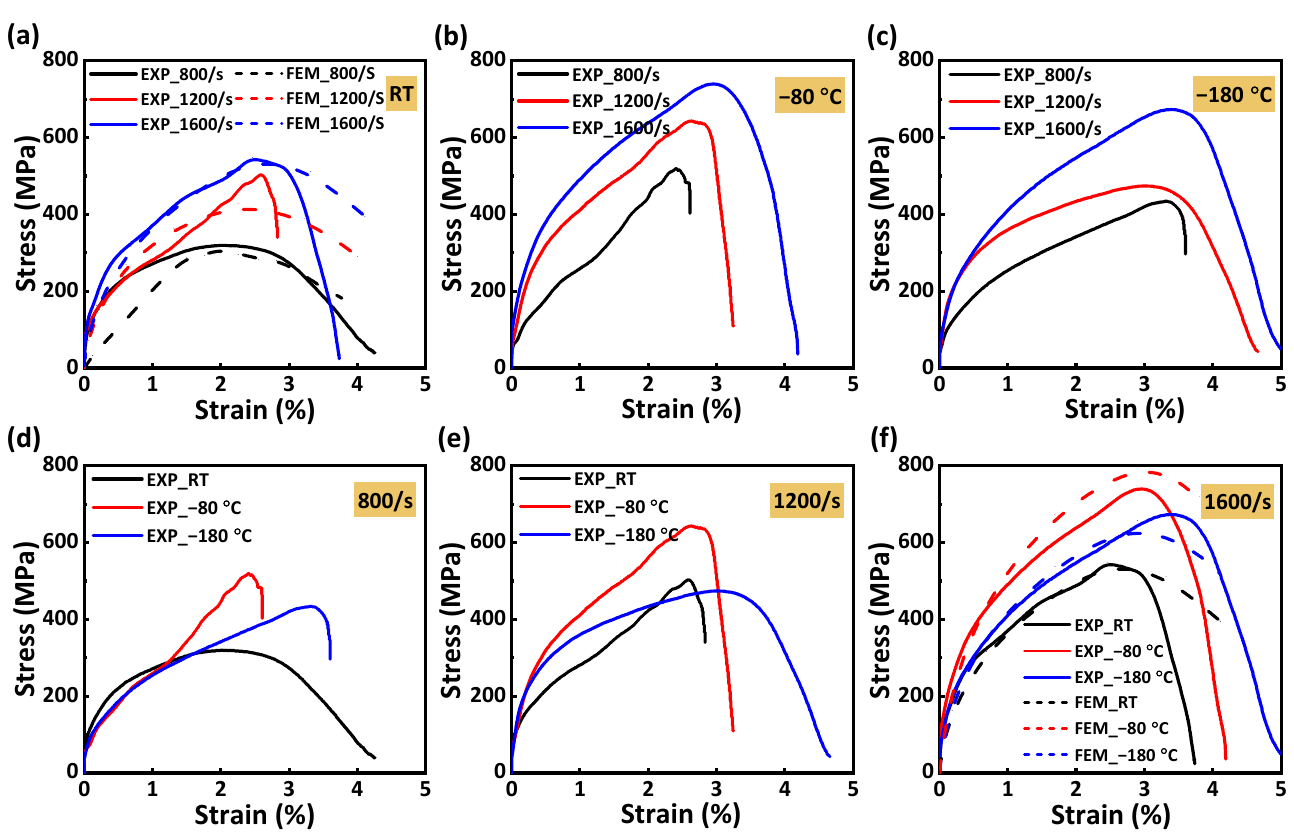
Figure 6. Stress–strain curves of the dynamic compression samples at di ff erent strain rates and temperatures: ( a ) room temperature; ( b ) −80 °C ; ( c ) − 180 °C; ( d ) 800 𝑠⁄ strain rate; ( e ) 1200 𝑠⁄ strain rate; ( f ) 1600 𝑠⁄ strain rate.